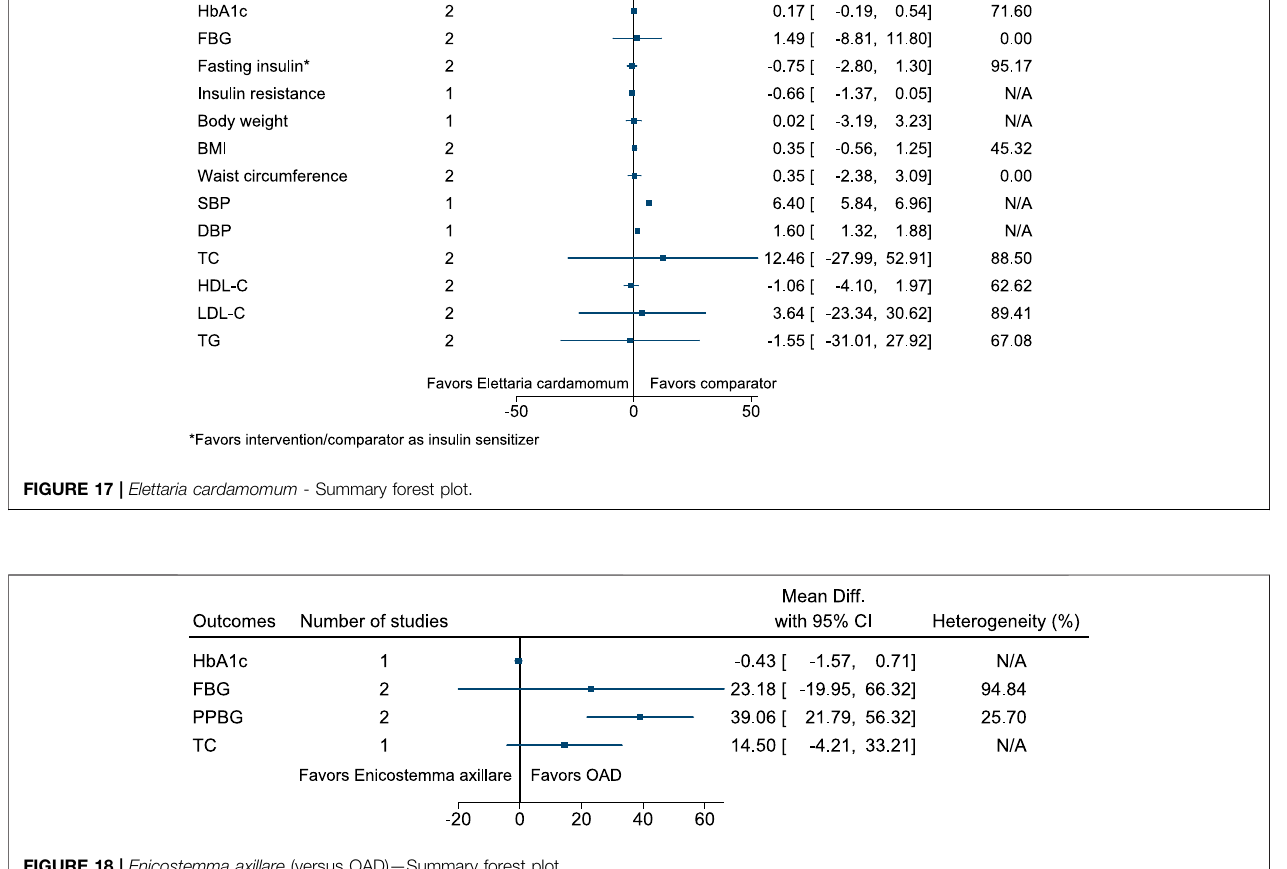
Frontiers in Pharmacology |